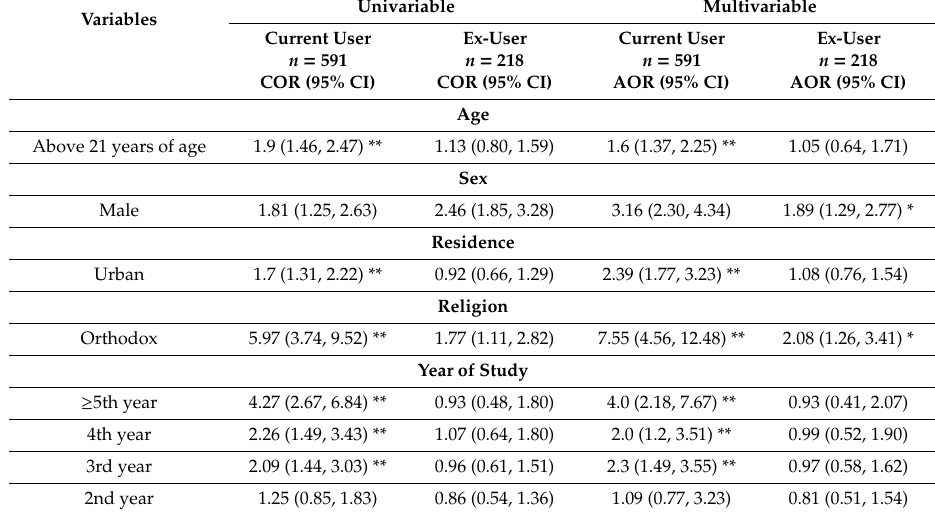
Key: COR = Crude Odds Ratio, AOR: Adjusted Odds Ratio. Reference category: for the dependent variable is “Never” and for the independent variables ≤ 21 years; female; rural; other religions (combined); 1st year of study; * p -value < 0.05; ** p -value <